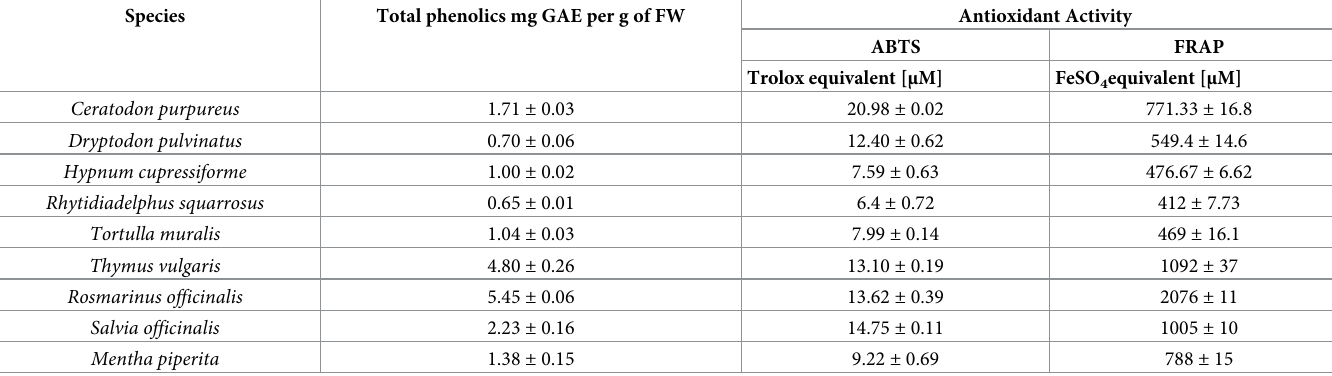
Table 6. TPC content and antioxidant activity of mosses extracts in comparison to accepted medical plants.